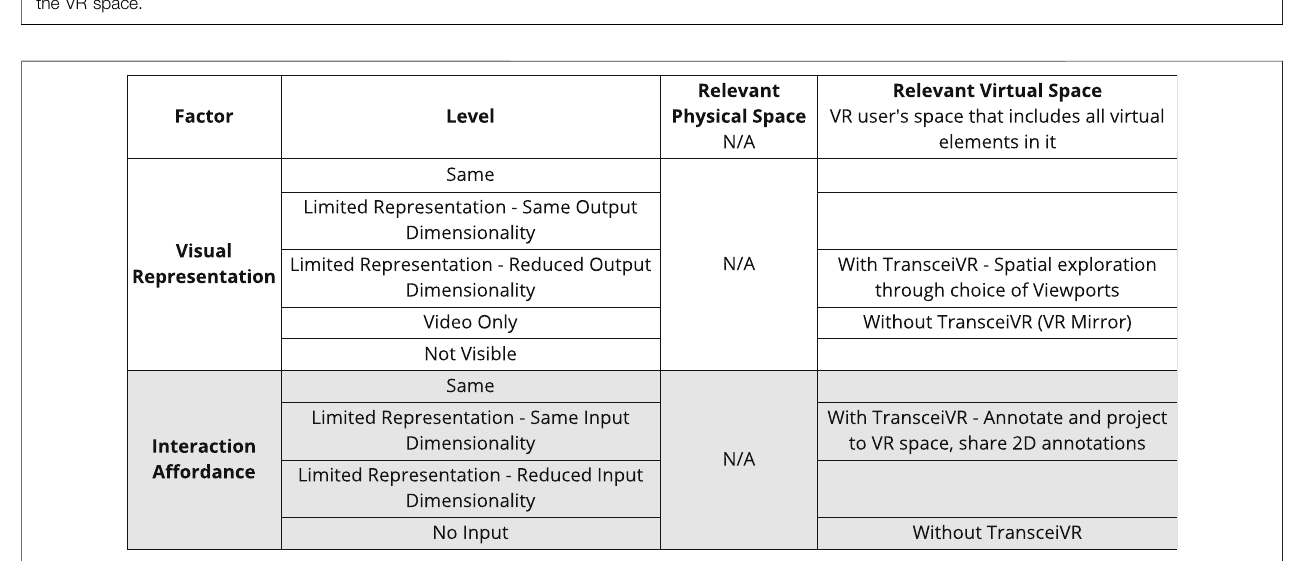
FIGURE 13 | Role of Interactive Mixed Dimensional Media in facilitating live communication between a user operating a 2D UI and VR user.